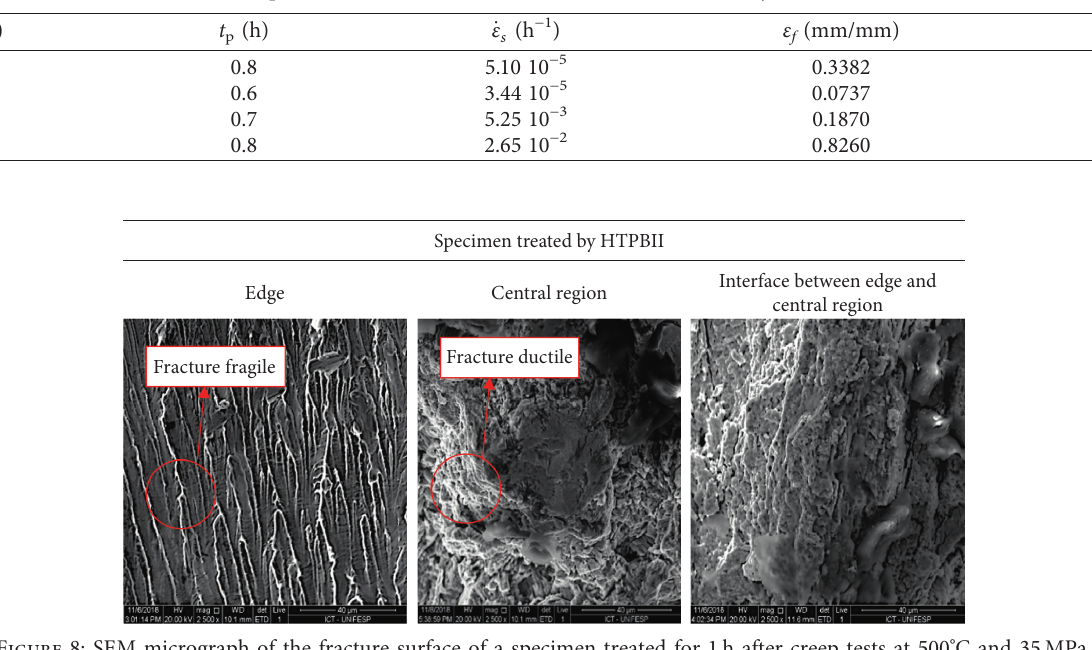
Figure 7: Typical creep curves of niobium treated by HT-NPBII for 1 h submitted to creep tests at 500 ° C and loads between 25 and 40MPa. Table 3: Creep data at 500 ° C and 35–40MPa of niobium treated by HT-NPBII for 1h.